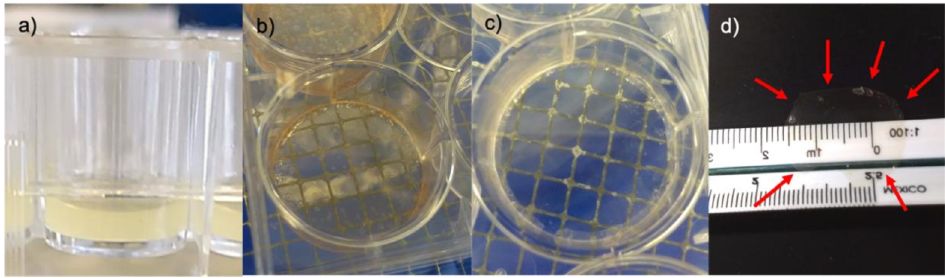
Figure 3. Desiccation process: ( a ) gel before vitrification; ( b ) membrane with phenol red; ( c ) rinsed membrane at day 37; and ( d ) membrane removed from the cast and dried at room temperature.